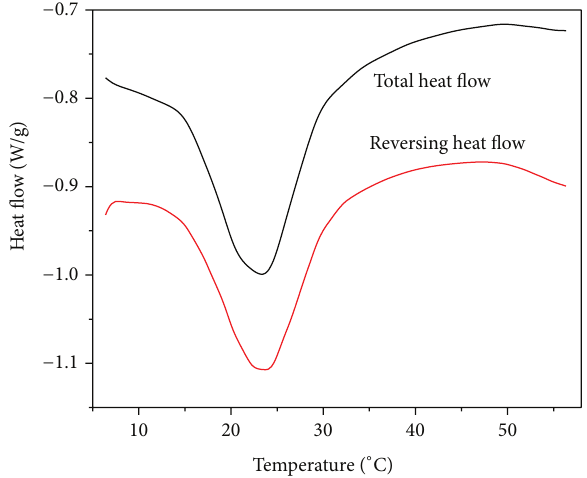
Figure 2: TM-DSC thermograms of PNIPA-SA/water (20%/80%) system in equilibrium swelling degree, upon heating rate of 5 K/min and cooling rate of